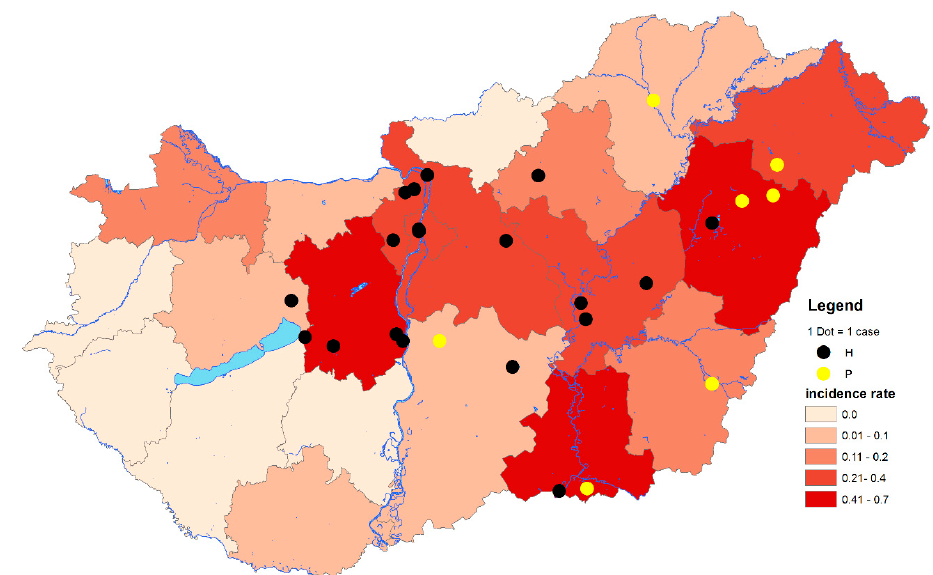
Figure 1. Geographical distribution of West Nile virus (WNV) polymerase chain reaction (PCR)-positive cases at the LAU 2 level and cumulative incidence rates of autochthonous and imported human WNV infections at NUTS 3 level of Hungary, from 2014 through 2017. The total number of human WNV cases between 2014 and 2017: n = 103. Black dots indicate PCR-positive samples containing histidine at amino acid position NS3249. Yellow dots indicate PCR-positive samples containing proline at amino acid position NS3249. LAU 2: Local Administrative Units level 2. NUTS 3: Nomenclature of territorial units for statistics level 3. IR: Incidence rates (number of WNV human infections / 100,000 inhabitants).